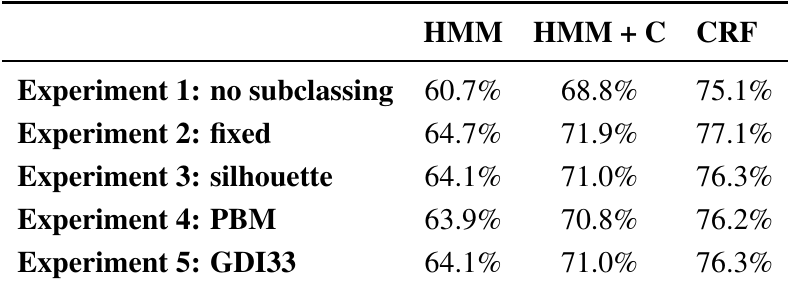
Table 4. Overall accuracies for the five experiments for the two